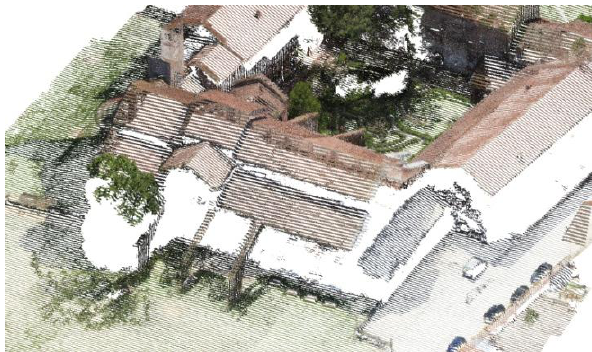
Figure 27. Point cloud extracted from Photoscan. This zoom on the Church allows to notice the noise affecting the cloud.